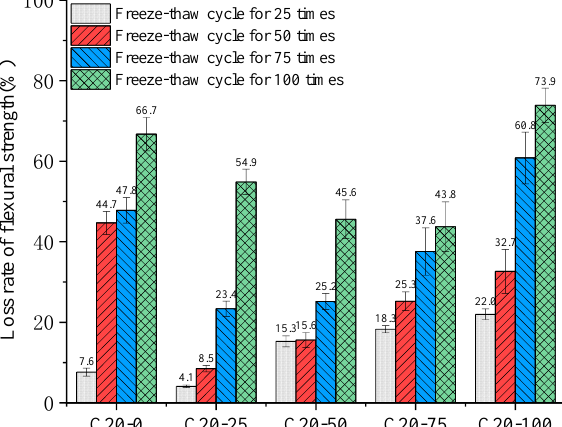
Figure 13. Loss rate of flexural strength of C20 concrete under freeze – thaw cycles.